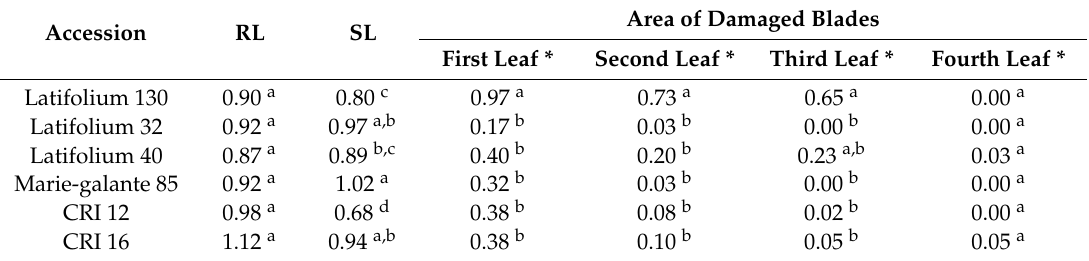
Table 2. Phenotype of six G. hirsutum accessions at 48 h post to complex alkali-saline